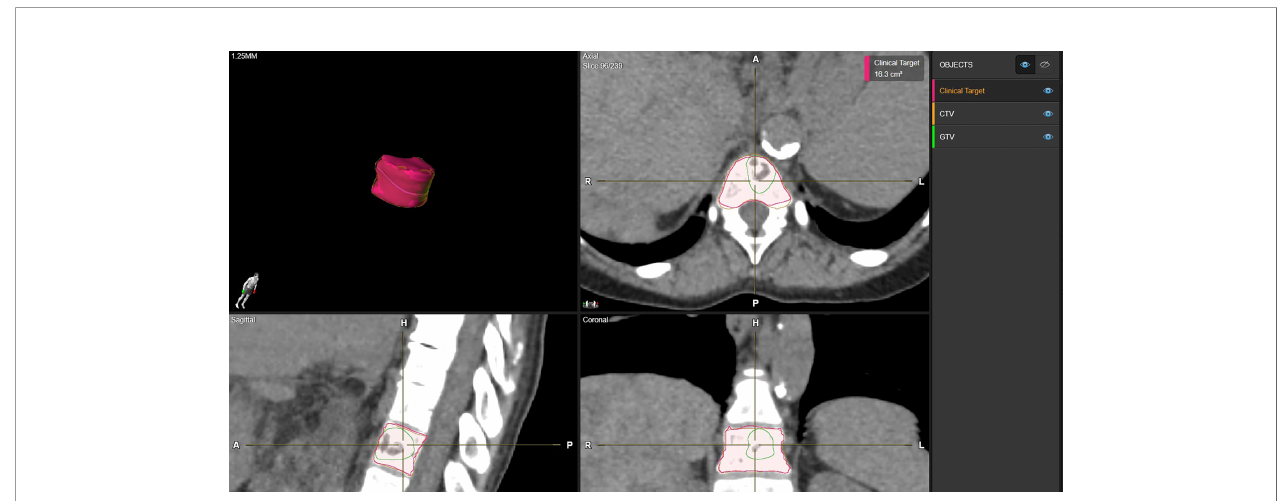
FIGURE 2 | Examples of CTV delineation by manual method and ESS in axial, sagittal, coronal, and 3D views. Green: clinically used GTV. Orange: clinically used CTV. Red: ESS-generated CTV, labeled as Clinical Target in Elements.